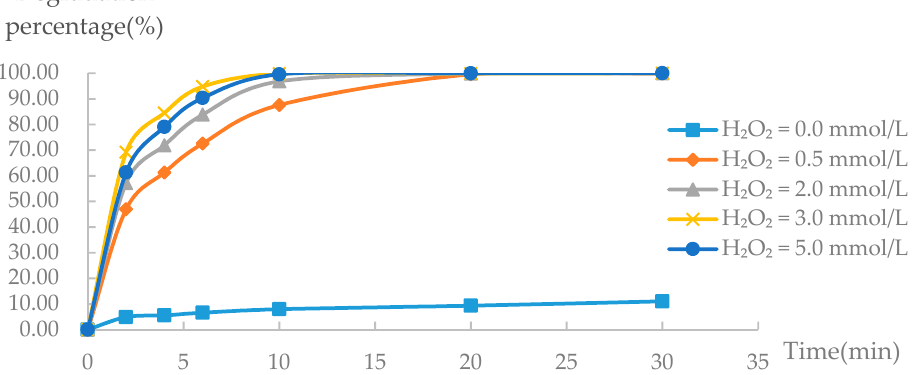
Figure 4. The influence of H 2 O 2 concentration (0–5 mmol/L) on trimethoprim degradation.